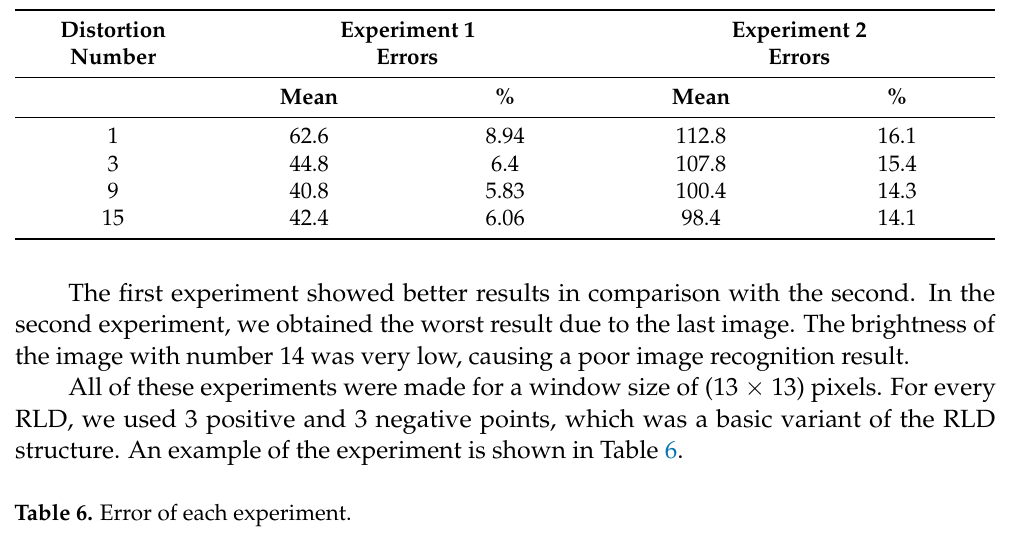
Table 5. Results of two experiments.